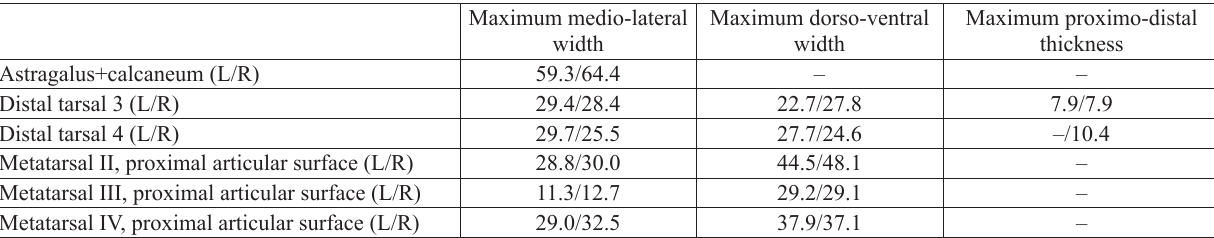
Table 1. Measurements (in mm) of tarsals in RAM 6794. Abbreviations: L, left; R,